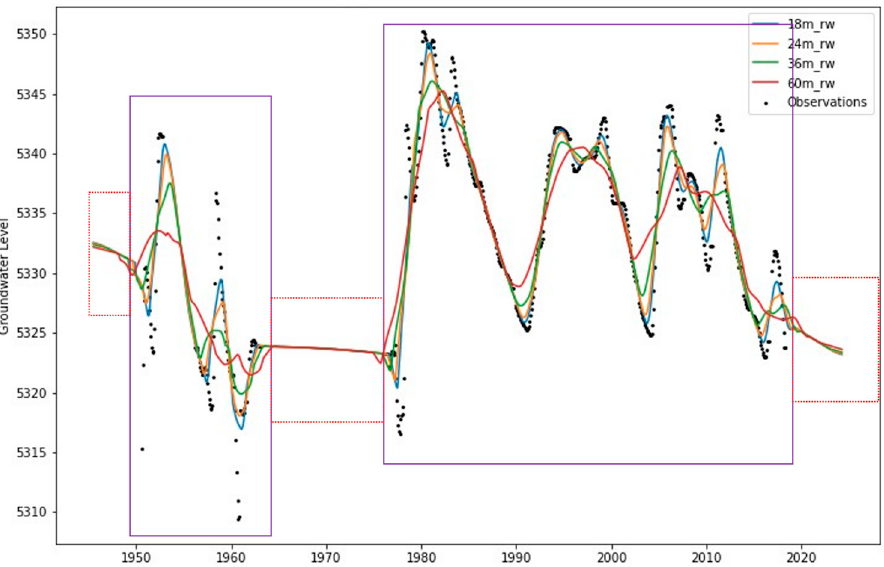
Figure 8. The long-term groundwater trends are regressed with other climatic features in time periods shown in purple boxes, and values are regressed in periods shown in red boxes.